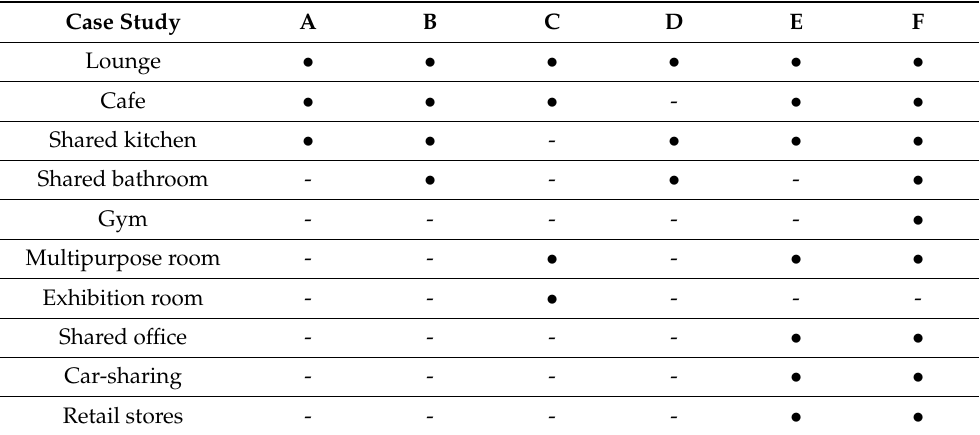
Table 9. Components of communal space in each case study (yes • , no